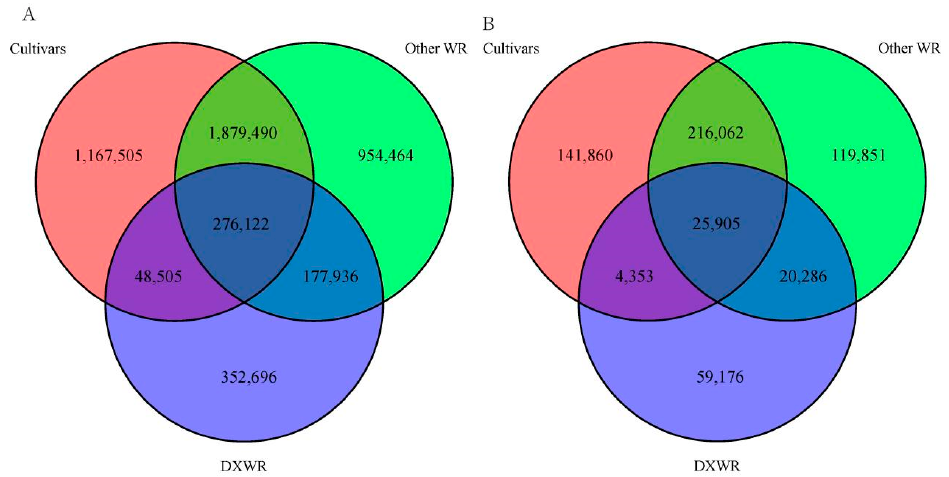
Figure 2. Venn of SNPs ( A ) and Indels ( B ) between DXWR, cultivated rice, and other common wild